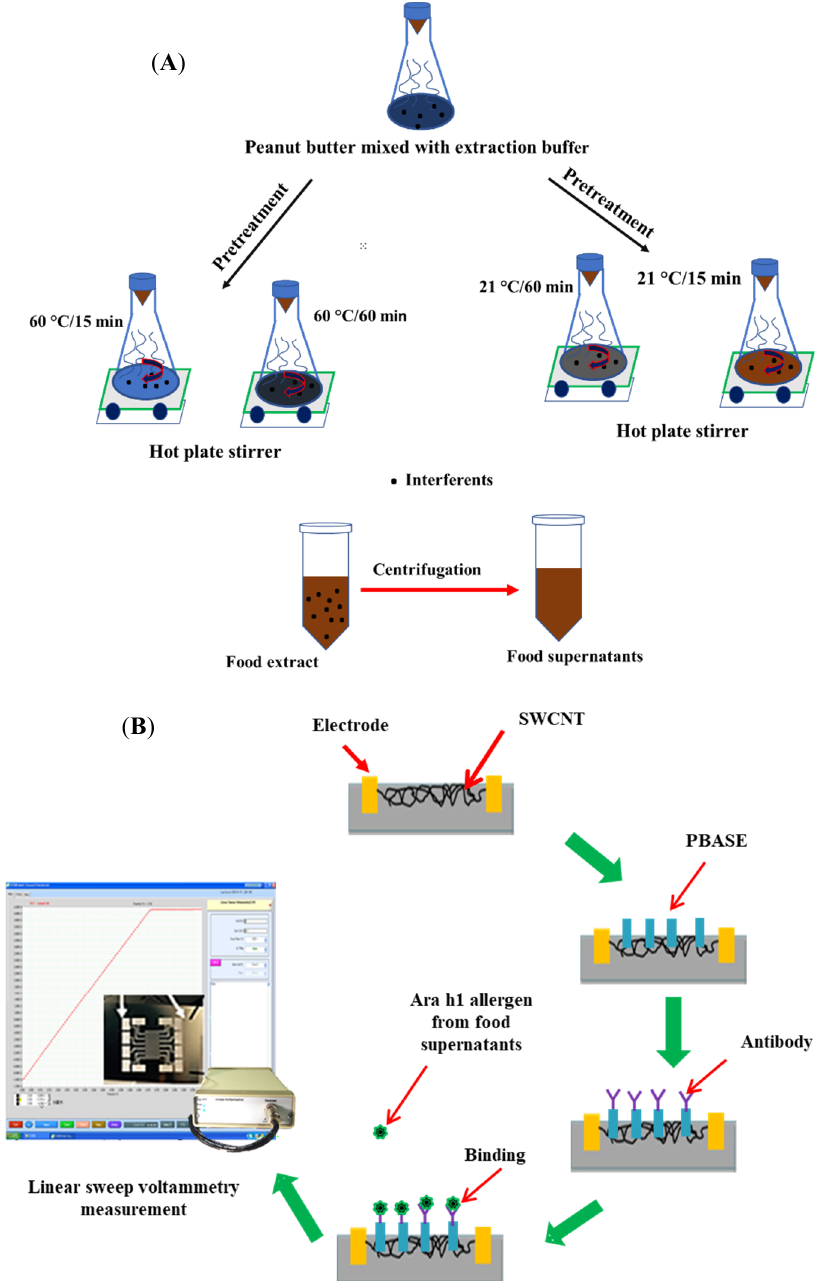
Figure 1. Schematic diagram ( A ) of pretreatment process of peanut butter foods using the buffer extraction method and the display ( B ) of the manufacture of the single-walled biosensor device for Ara h1 detection and set up for biosensor measurement using a potentiostat. SWCNT: Single-walled carbon nanotube; PBASE: 1-pyrenebutanoic acid, succinimidyl ester.